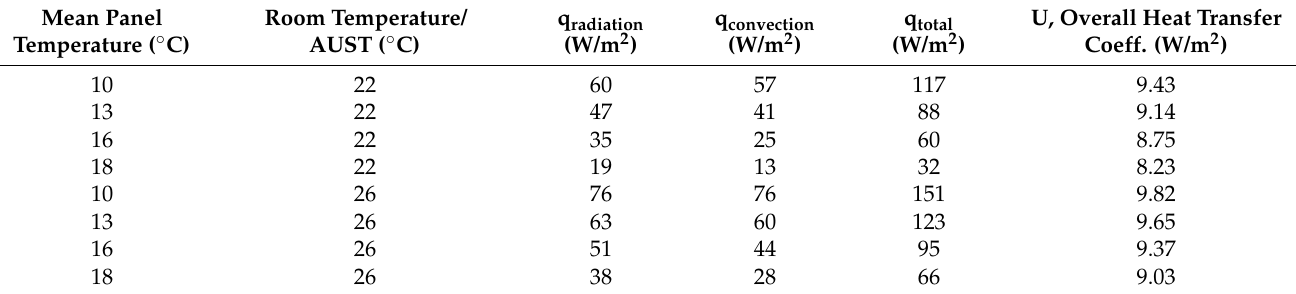
Table 1. Heat transfer